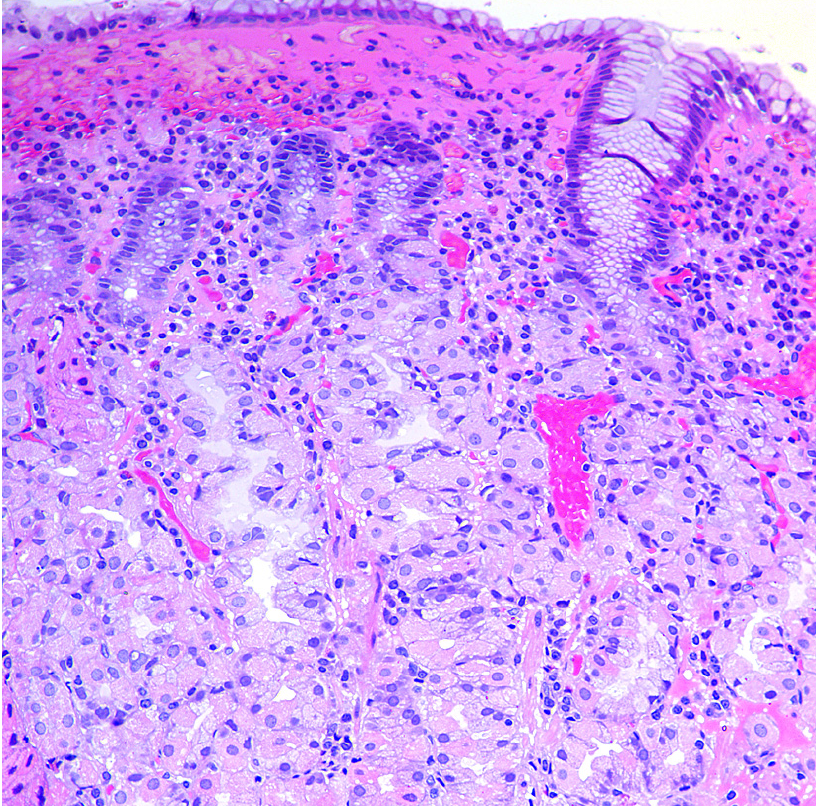
Figure 1. Autoimmune gastritis: initial stage. Biopsy from the gastric body. Lymphoplasmacytic inflammatory infiltration of the lamina propria with damage to the fundic glands. Hematoxylin and eosin stain. ×200 (from the personal archive of Professor S.I. Mozgovoi). In the second stage, or expanded (florid) stage, pronounced atrophy of acid-producing glands develops; diffuse lymphoplasmacytic infiltration of the lamina propria is charac- teristic of a decrease in the height of the glands and an increase in the thickness of the foveolar component. The prevalence of intestinal metaplasia is higher than in the previous phase, but pseudopyloric metaplasia plays the main role in the remodeling of gastric mucosa (Figure 2). In recent years, this type of metaplasia, with the formation of